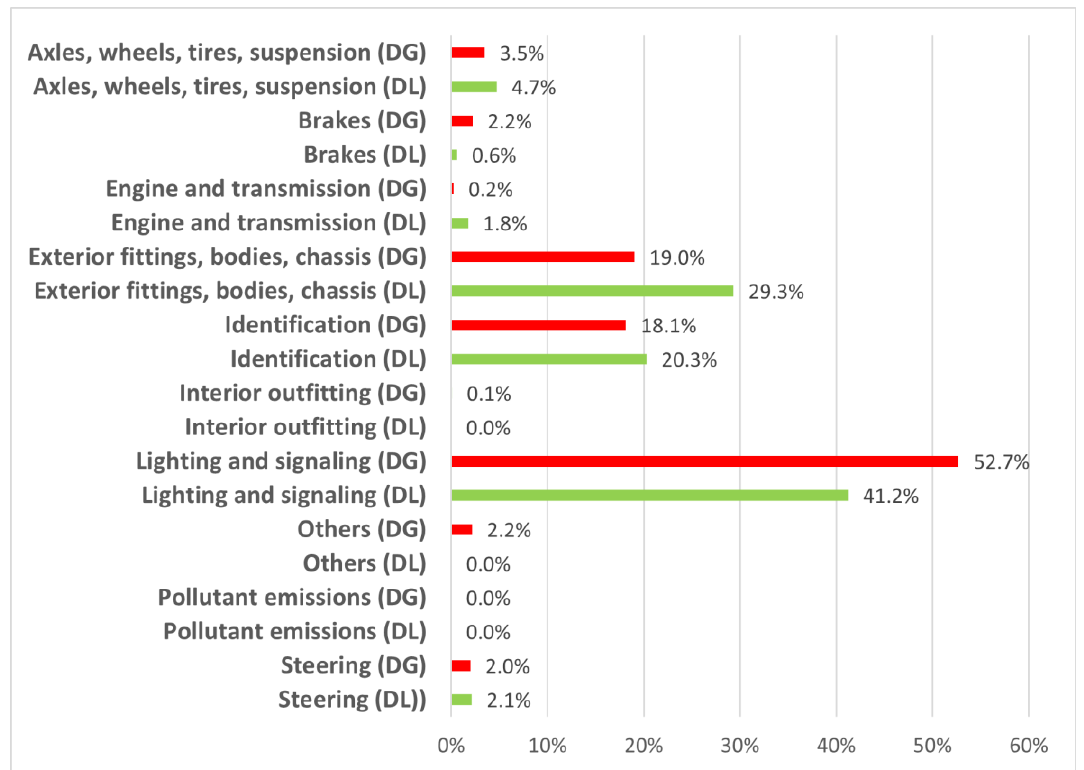
Figure 2. Percentage of serious defects (DG) and minor defects (DL) in 2005 – 2020.